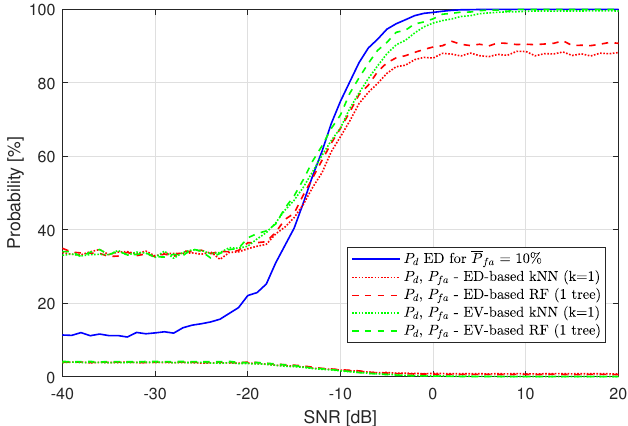
Figure 11. Probability of detection P d comparison of the Energy Detection-based and Energy Vector-based k-Nearest Neighbors and Random Forest methods for ¯ P fa =